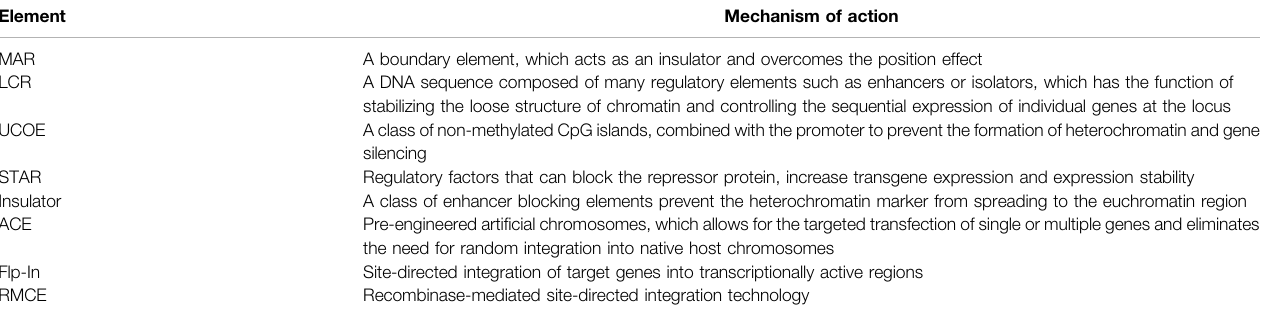
TABLE 2 | Optimization strategies of integration site and position effect for improving recombinant antibody expression. Element Mechanism of action